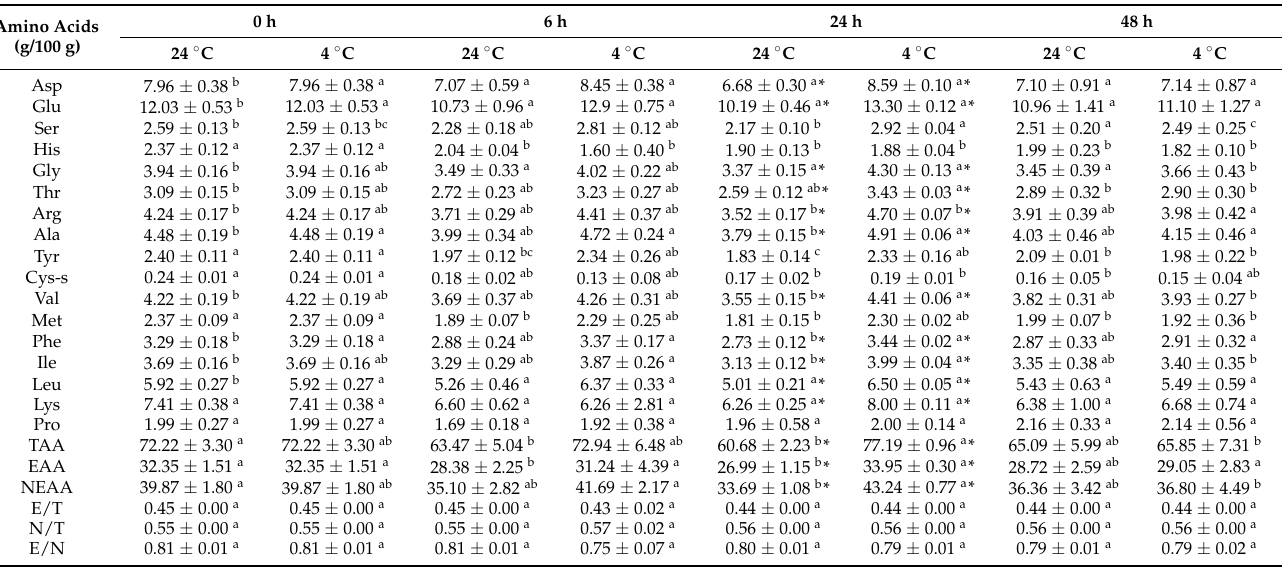
Table 5. Hydrolyzed amino acids content of American shad as storage progressed at 24 ◦ C (unrefrig- erated) and 4 ◦ C (refrigerated).